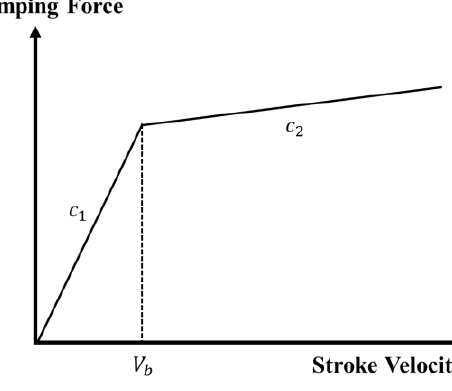
Figure 15. Piecewise bilinear damping characteristic. Table 3. Required input current 𝐼 𝑀 and 𝐼 𝐵 for implementing some desired 𝑐 1 and 𝑉 𝑏 .